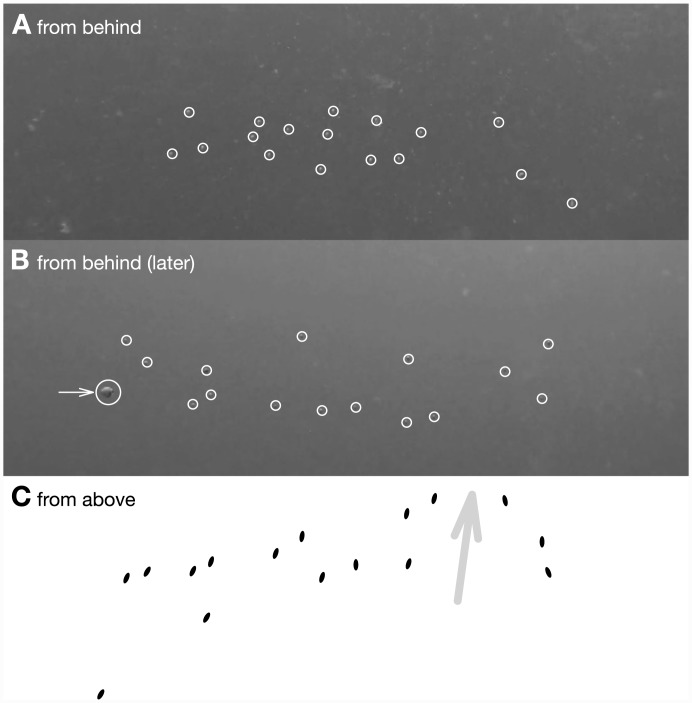
Configuration of groups of C. atripectoralis swimming.A and B: frames of a video shot while following a test group of 17 larvae (from behind); larvae are circled for clarity (video by C. Paris and R. Paris provided as supplementary material S1 Video). In B, the arrow points an individual on the verge of disconnecting from the group. C: sketch of what the group in B would typically look like from above. The grey arrow shows the direction of swimming recently initiated by a few individuals on the right side of the group.